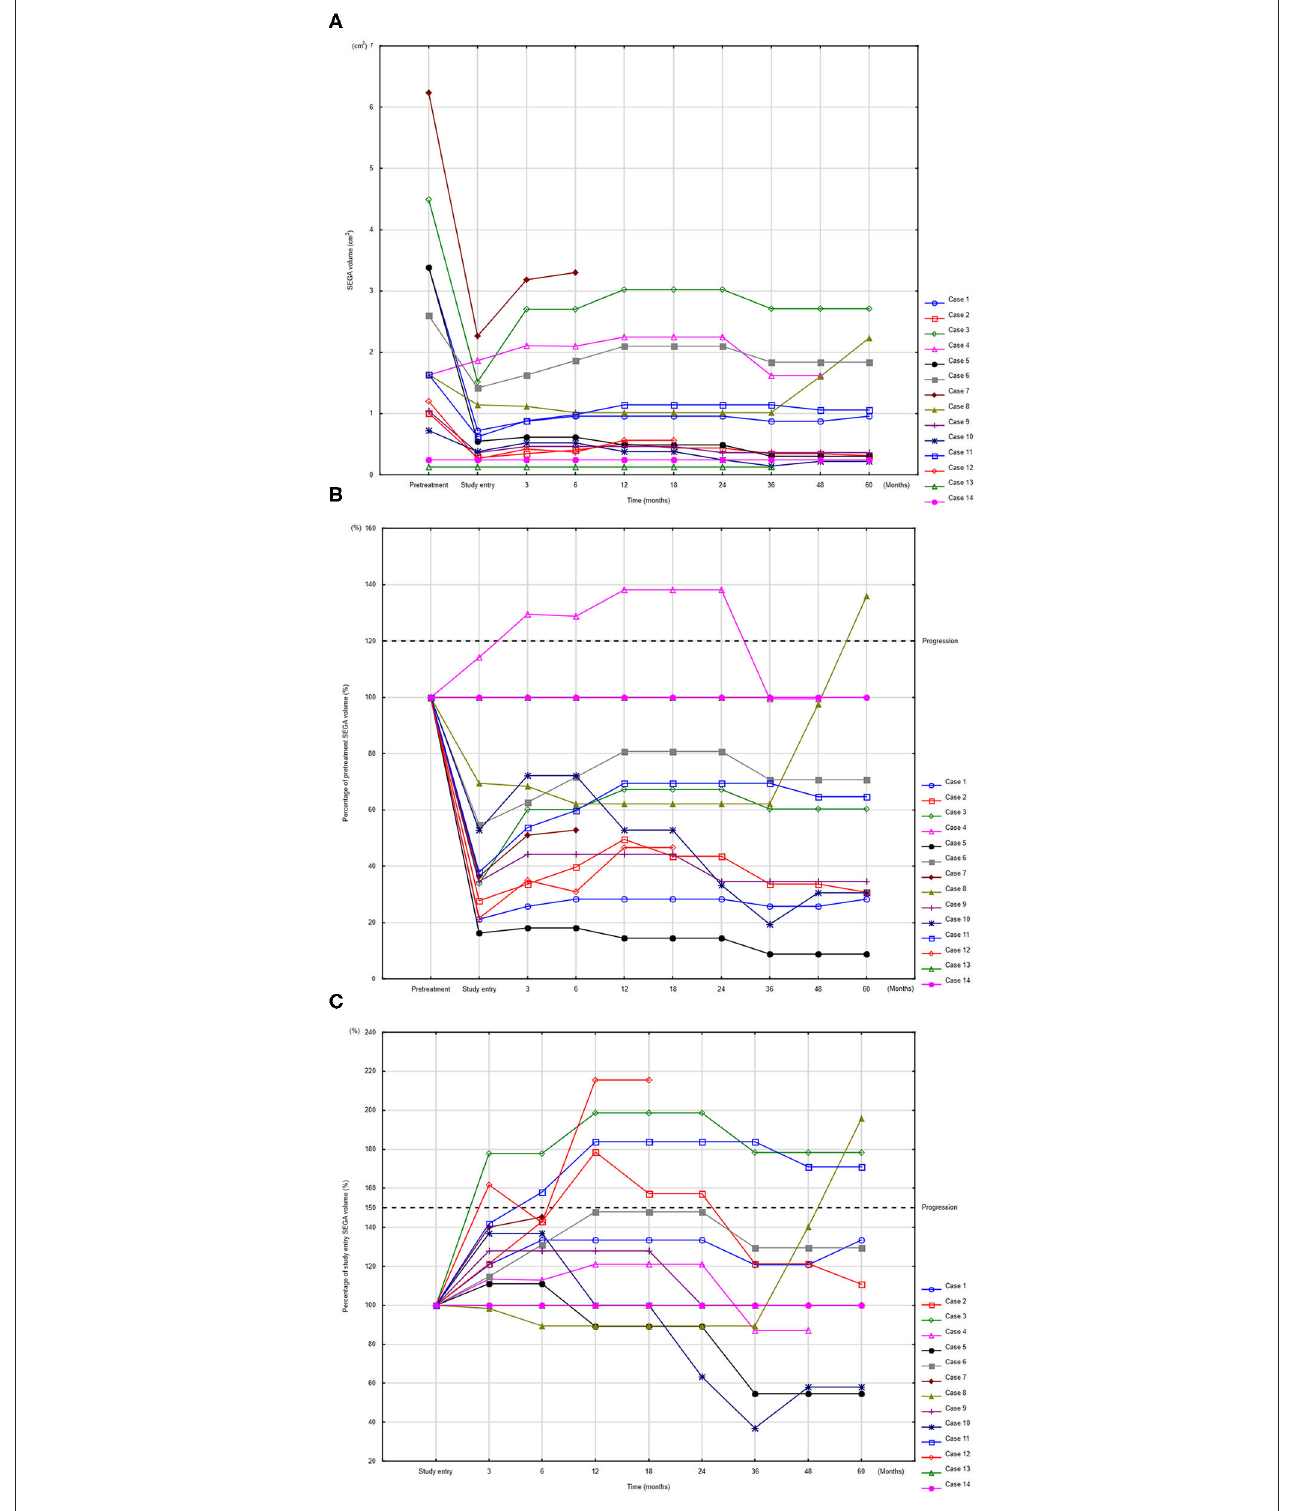
FIGURE 2 | Changes in SEGA volume (SV) compared to volume before everolimus treatment (A) , and percentages of SV change at study time point compared to pretreatment measurements (B) and to study entry (C) . To identify respective individuals, the indices for each patient are consistent among panels (A–C) . Progression defined according to RECIST (B) and according to EMINENTS study (C)